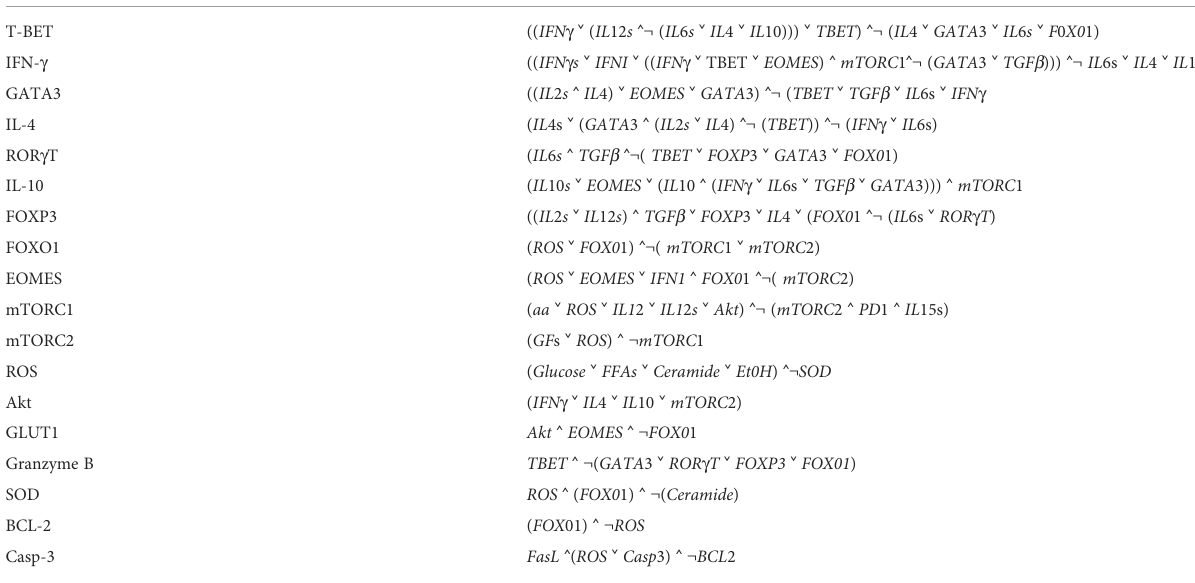
TABLE 1 Logic rules of the CD8+ T cells gene regulatory network. Node